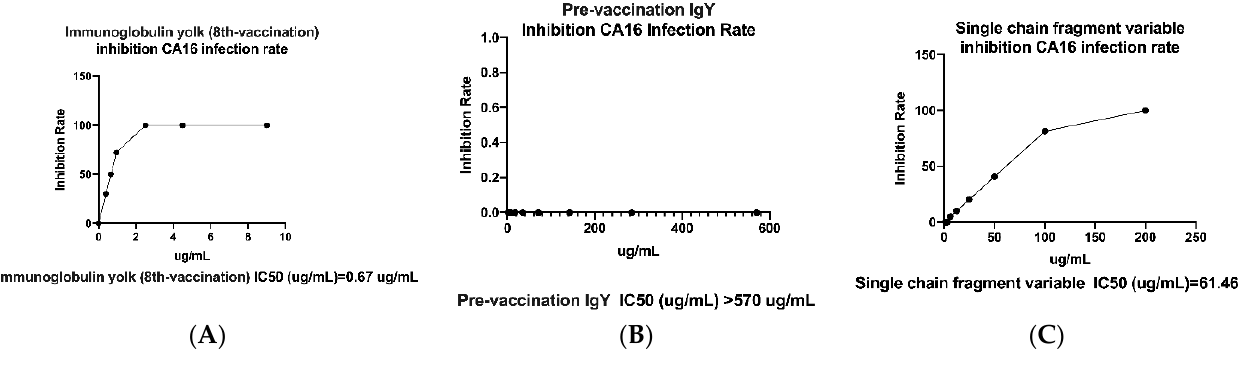
Figure 7. Analysis of IgY and scFv neutralizing activity against coxsackievirus A16. ( A ) Pre-vaccination IgY as negative control antibody with an IC 50 greater than 570 µg/mL. ( B ) Immunoglobulin yolk (8th vaccination) antibody with an IC 50 equal to 0.67 ± 0.06 µg/mL. ( C ) Scheme 50. equal to 61.46 ± 1.75 µg/mL. All experiments were carried out in triplicate. The results are presented as means plus or minus standard deviation.